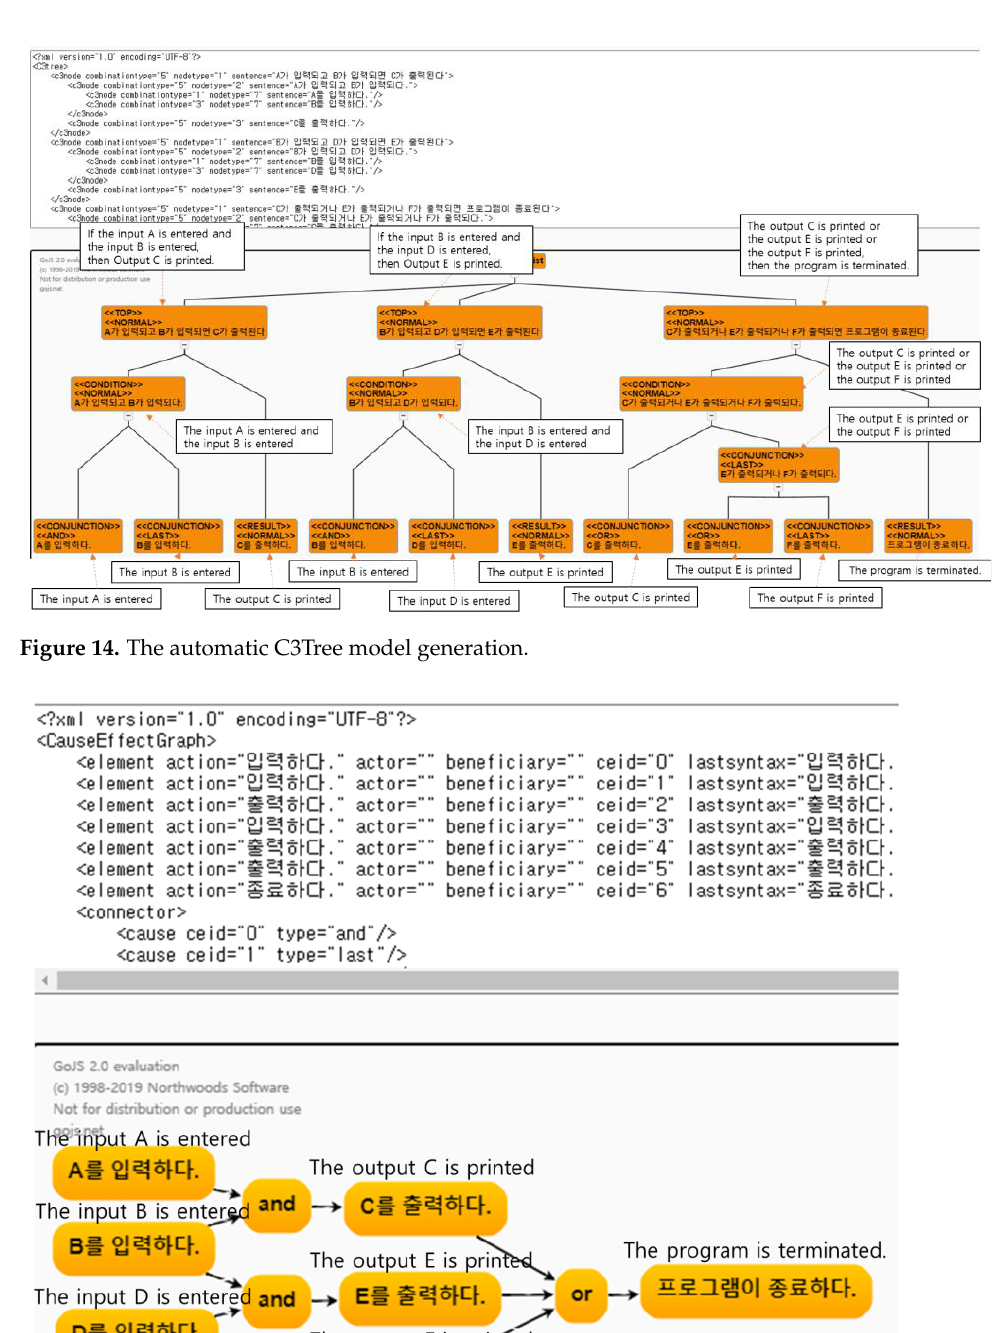
Figure 15. The automatic cause – effect graph generation.